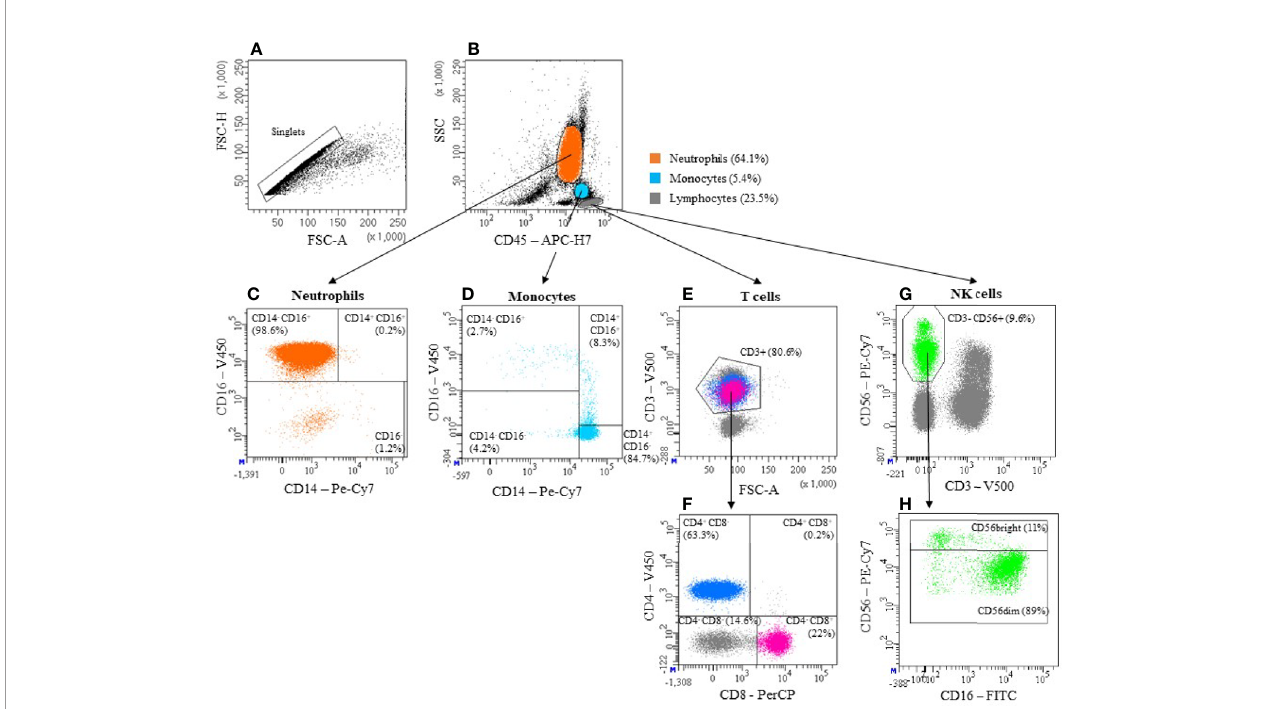
FIGURE 1 | Gating strategy. The basis of all measurements in this publication is the gating strategy shown here. After exclusion of doublets (A) , Neutrophils, Monocytes and Lymphocytes were identi fi ed based on the expression of CD45 and granularity (SSC) (B) . Neutrophils are also de fi ned by high CD16 and low CD14 expression (CD14-CD16+) (C) . Monocytes can be categorized into 3 subpopulations, based on their expression pattern of CD14 and CD16: i) “ classical ” CD14+CD16-, ii) “ intermediate ” CD14+CD16+ and iii) “ non-classical ” CD14-CD16+ (D) . T cells were de fi ned as Lymphocytes expressing CD3 (E) . By confronting CD4 and CD8 we then identi fi ed cytotoxic T cells (CD4 - CD8 + ) and T helper cells (CD4 + CD8 - ) (F) . Among Lymphocytes, those cells that express CD56 but not CD3 were de fi ned as NK cells (G) . They were further divided into a CD56dim (CD56 + ) and a CD56bright (CD56 ++ ) subset (H) . Antibody panels used can be found in Table 1